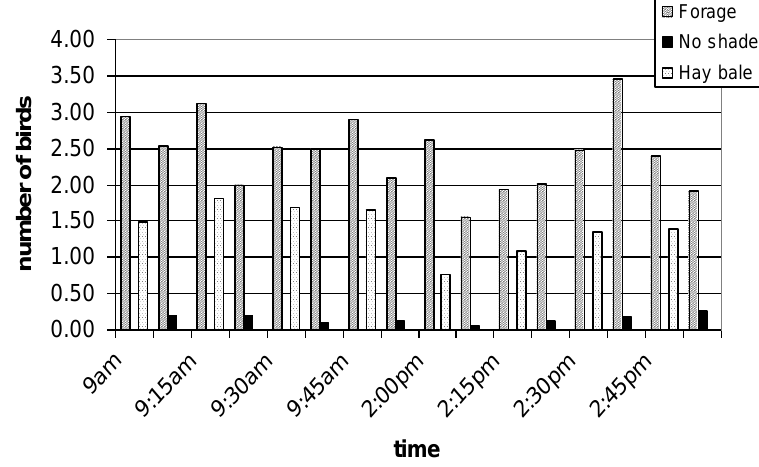
Figure 4. Average number of birds in forage, hay bale enriched and non shade areas over a